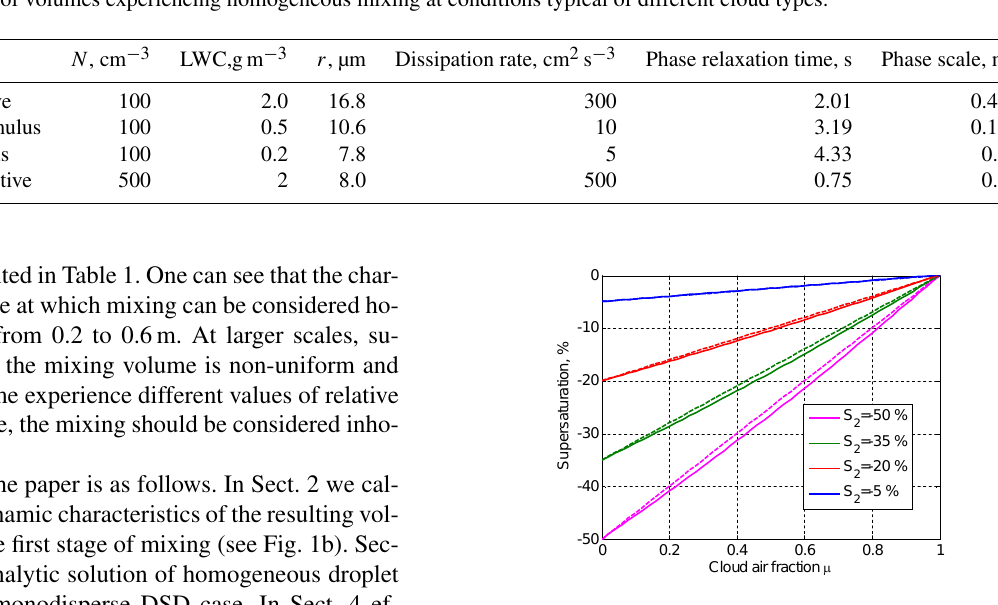
Figure 2. Dependence of supersaturation on parameter µ : simula- tion results (solid line) and an approximate linear dependence cal- culated using Eq. (6b) (dashed line). The initial temperatures of two volumes are T 1 = 8 ◦ C and T 2 = 10 ◦